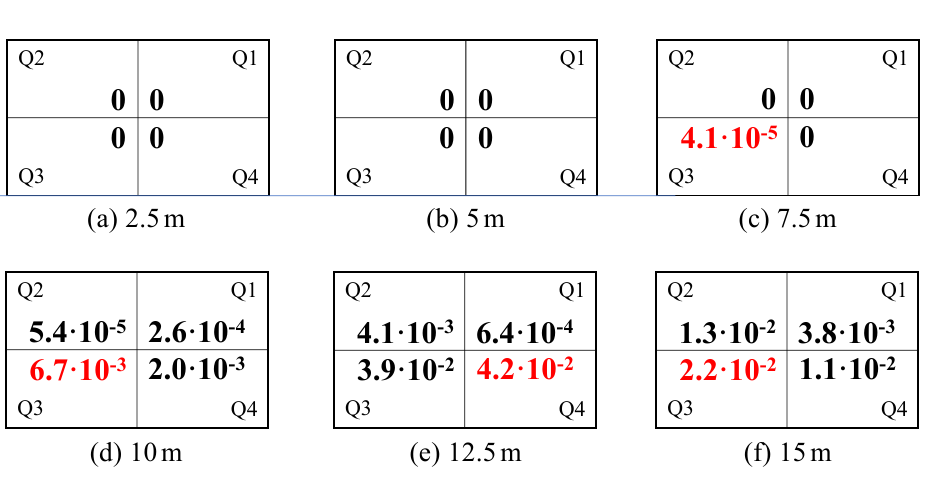
Figure 8. Freeze intensities observed in each quadrant for the different